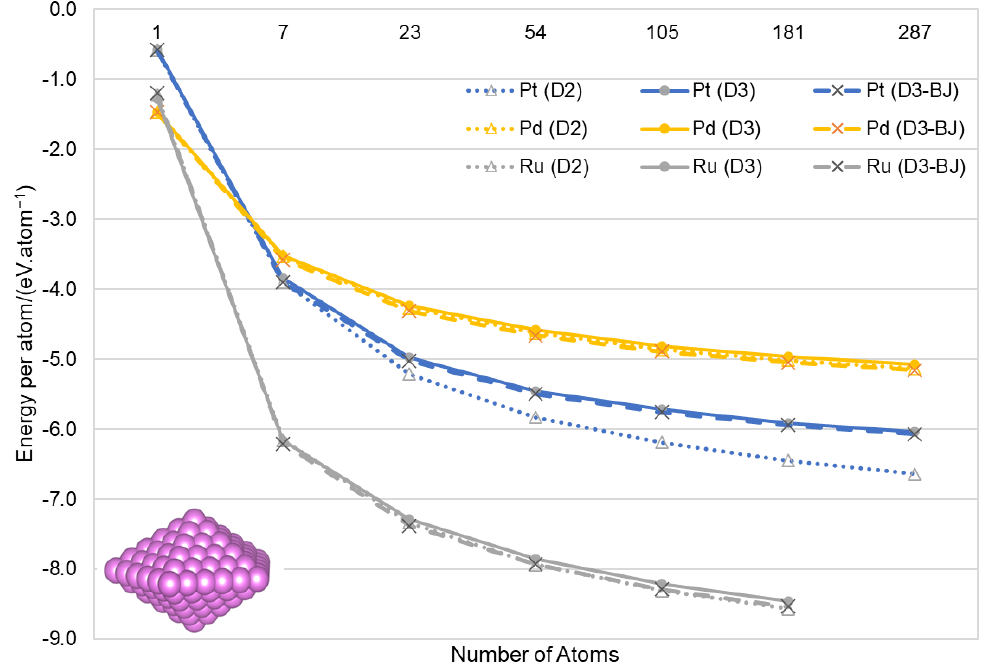
Figure 4. Energy per atom as a function of size for decahedral Ru, Pd and Pt nanoparticles calculated with the three modelling methods, DFT-D2, DFT-D3 and DFT-D3(BJ). The data for the energies per atom for the cuboctahedral Ru, Pd and Pt nanoparticles of increasing sizes are shown in Figure 5. The data follow similar trends to the icosahedral and decahedral structures, where the energy per atom increases as the size increases. Cal- culating the surface-to-bulk atom ratios, we again see a decreasing trend of 12.00, 3.23, 1.67 and 1.10 for G m = 13, 55, 147 and 309, but for this shape, the number of bulk atoms did not exceed the surface atoms within the size range considered. Similar to the icosahedral data, all three calculation methods gave similar results for Pd and Ru, with the DFT-D2 method deviating again for Pt. Extrapolating the energies to larger nanoparticles indicates that the energy per atom reaches values above − 5 eV/atom for Pd, − 6 eV/atom for Pt and − 8 eV/atom for Ru, which correlates with the bulk calculations shown in Table 1.